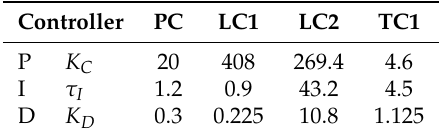
Table 6. PID controllers gains for single temperature control.